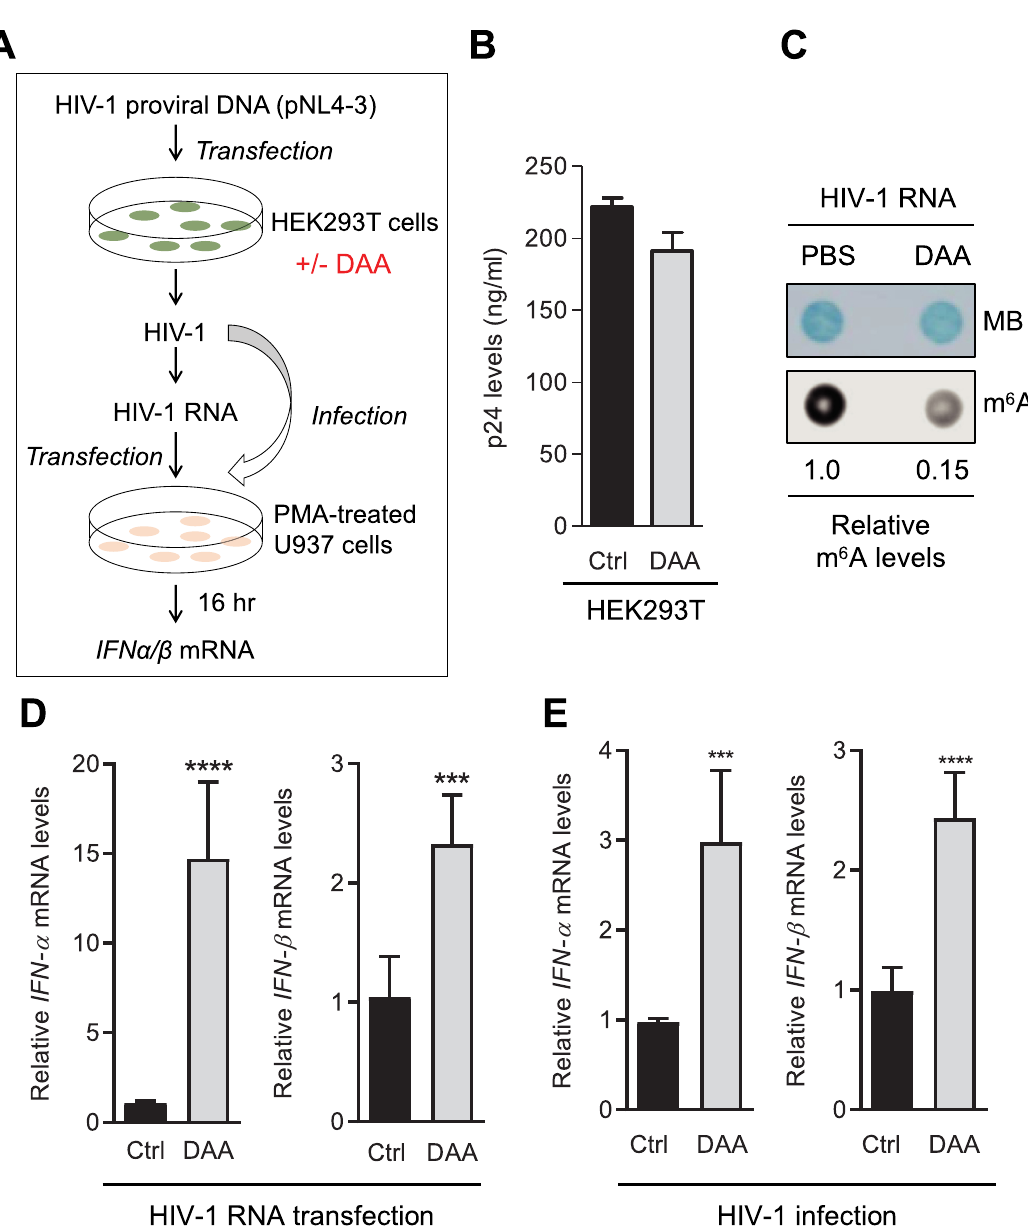
Fig 6. DAA-treatment reduces m 6 A modifications of HIV-1 RNA and increases IFN-I induction. (A) A schematic diagram of the experimental approach. HEK293T cells were treated with the solvent PBS control (Ctrl) or DAA (50 μ M) for 3 hr and then transfected with the HIV-1 proviral DNA pNL4-3. HIV-1 in the supernatants was collected 48 hr later. (B) HIV-1 p24 levels in the supernatants of HEK293T cells were measured by ELISA. (C) RNA (100 ng) from these viruses used for the m 6 A dot-blot assay. Methylene blue (MB) staining was used as an RNA loading control. (D) HIV-1 RNA (250 ng) from Ctrl and DAA-treated samples were transfected into PMA-differentiated U937 cells. After 16 hr, cells were collected for the analysis of IFN- α and IFN- β mRNA levels by RT-qPCR. The results are shown as means ± S.D. of three independent experiments. ��� P < 0.0005, ���� P < 0.0001. Un-paired t-test was used for statistical analysis. (E) HIV-1 (250 pg of p24) from HEK293T cells was used to infect PMA-differentiated U937 cells. At 16 hpi, U937 cells were collected for the analysis of IFN-I mRNA levels by RT-qPCR. The results are shown as means ± S.D. of three independent experiments. ��� P < 0.0005, ���� P < 0.0001, Ctrl samples were normalized with mock infection samples. Un-paired t-test was used for statistical